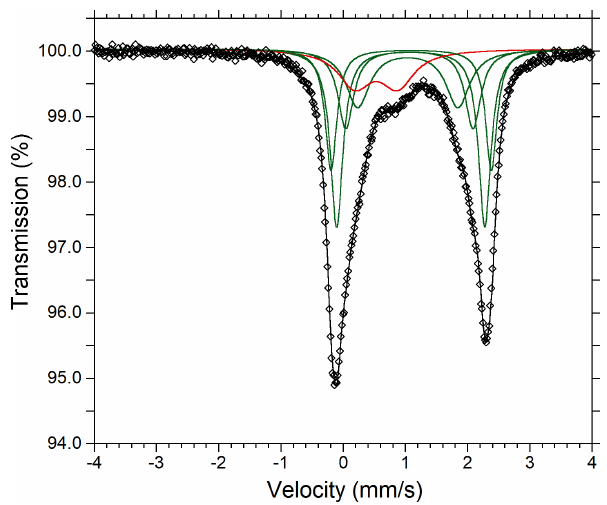
Figure 3. Mössbauer spectrum of tourmaline supergroup minerals (dutrowite and associated oxy-dravite). Fitted absorption doubled assigned to Fe 2 + and Fe 3 + are indicated in green and red colours, respectively. Diamonds denote measured spectrum, and the black curve represents summed fitted spectra. Table 6. Selected bond distances (in Å) for dutrowite.